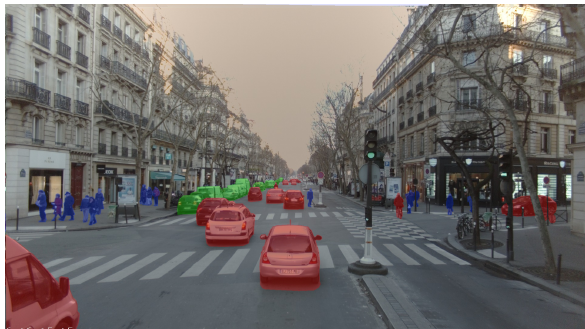
Figure 3: Moving object filtering input (manual segmentation) : pixels labeled as moving vehicles and pedestrians are discarded.